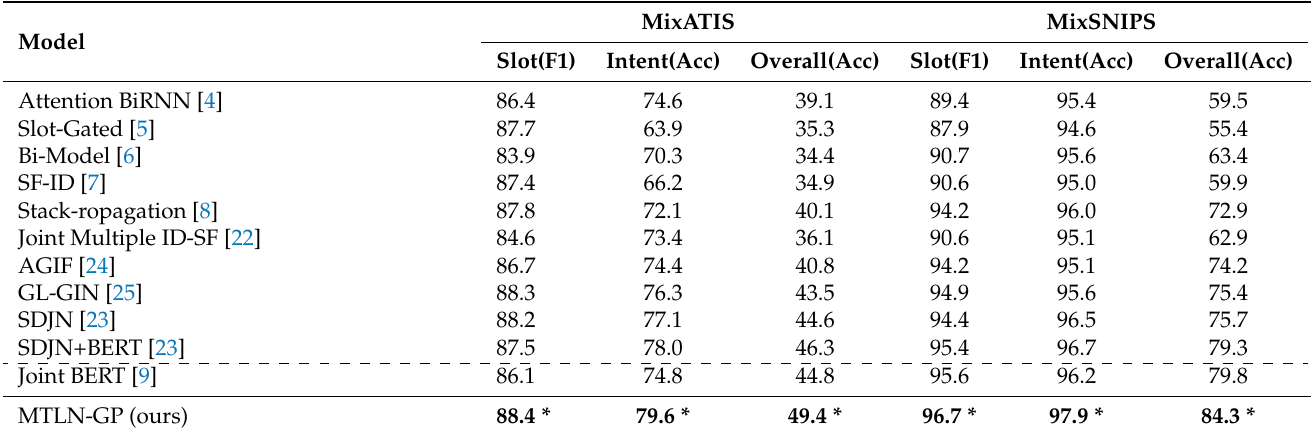
Table 2. Results of joint training on the MixATIS and MixSNIPS datasets. The values with * and bolded indicate that our framework has improved on all of its baselines (%).